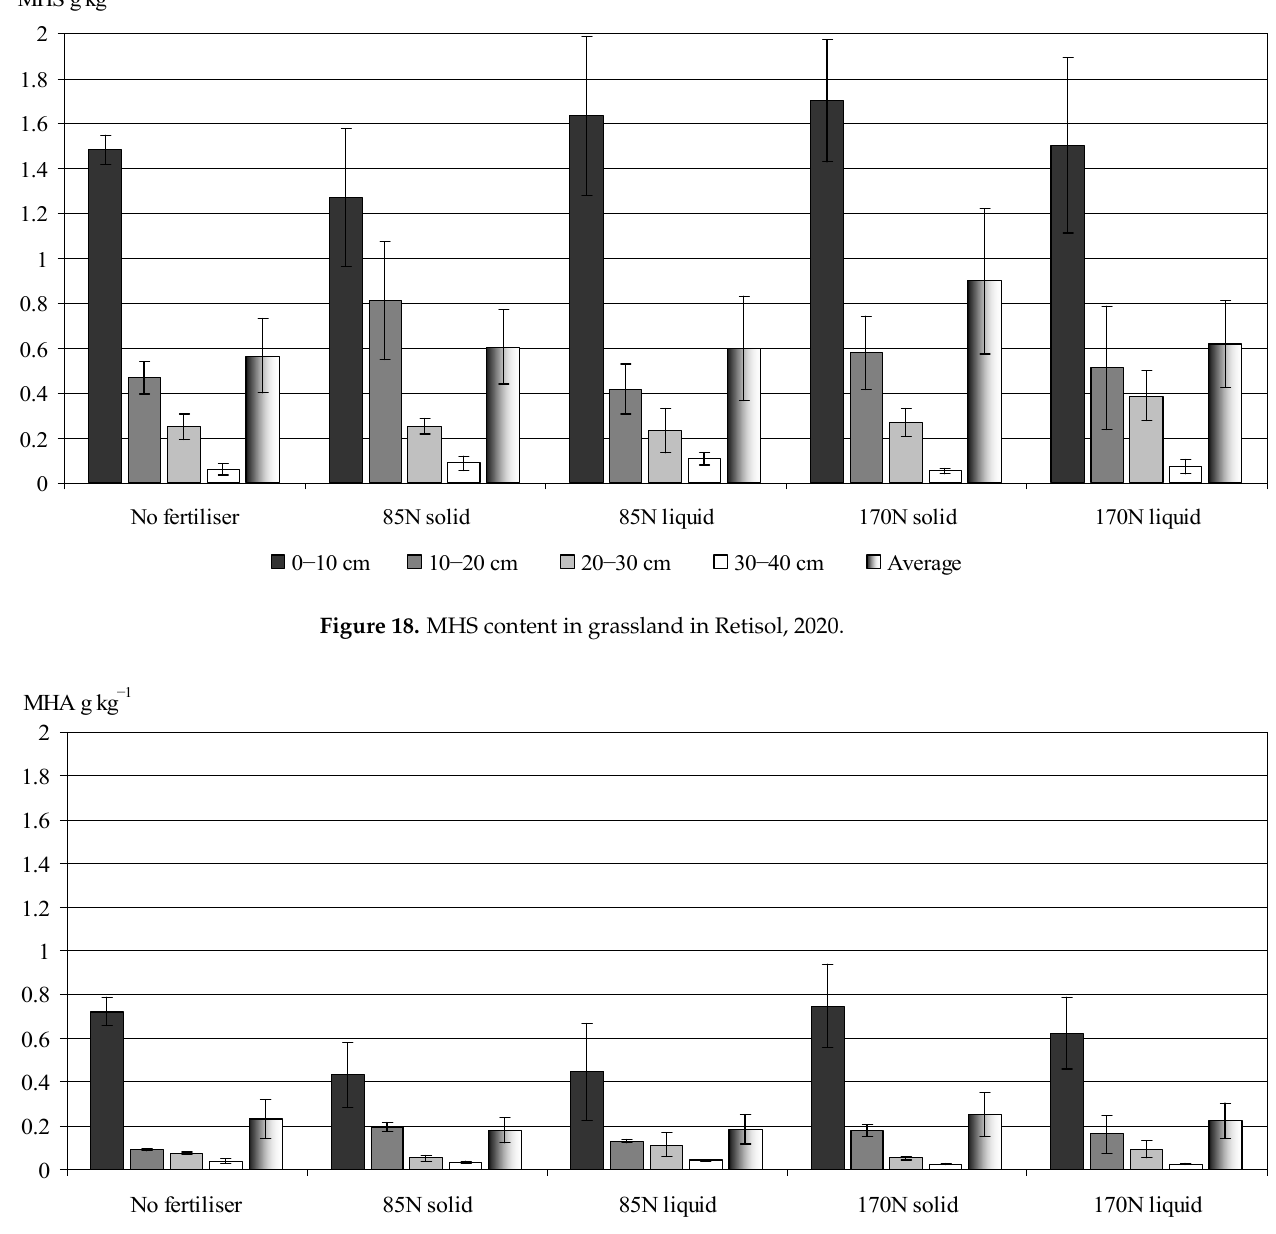
Figure 17. MHA content in grassland in Retisol, 2019 .